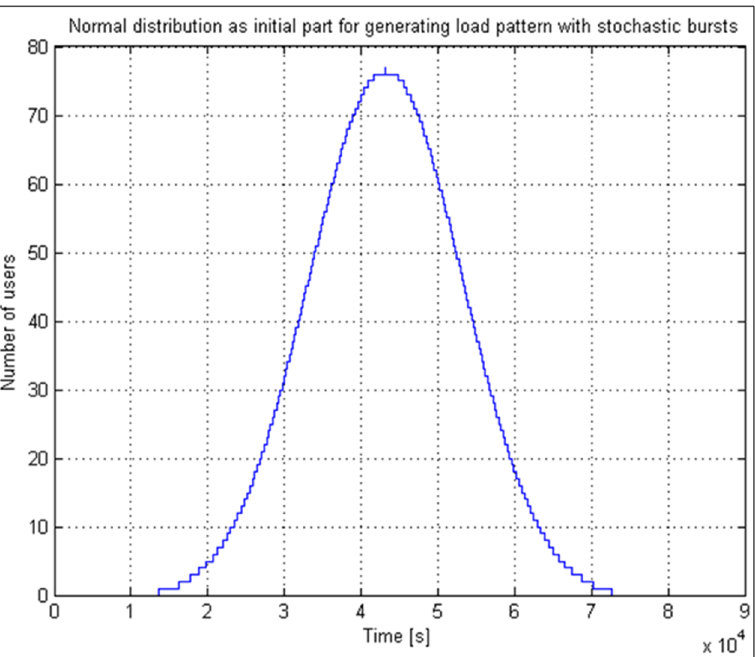
Figure 8. Left tail of a normal distribution, used as a basis for generating a random load pattern, together with stochastic bursts.